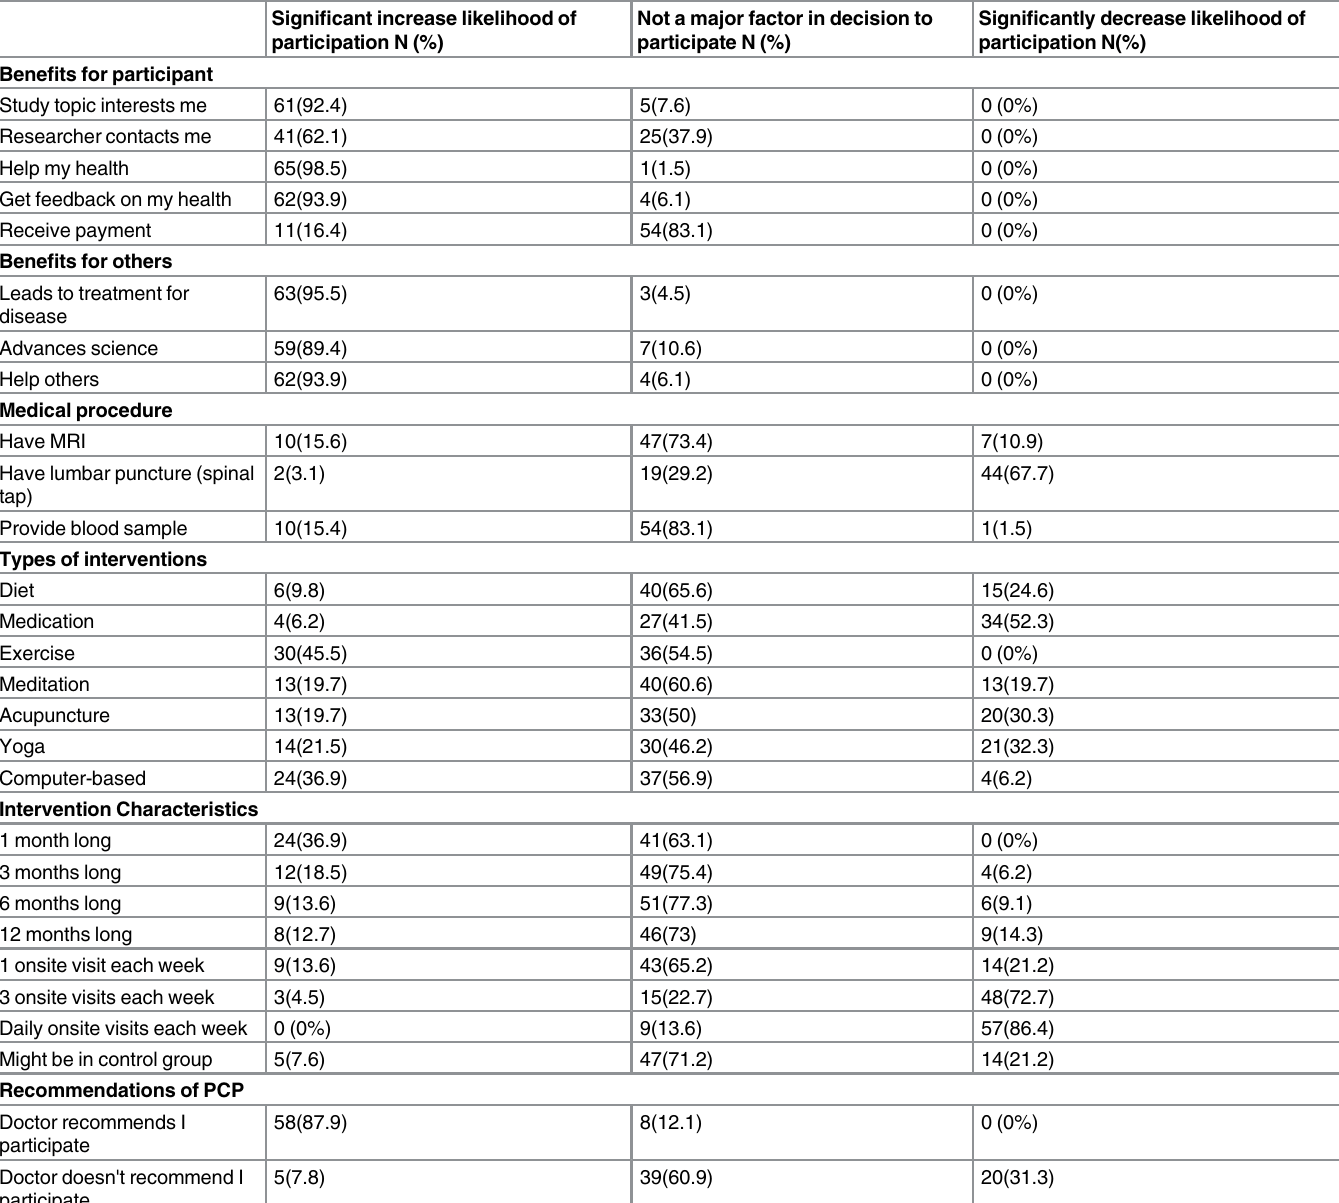
Table 1. Research Designs and Interest in Study